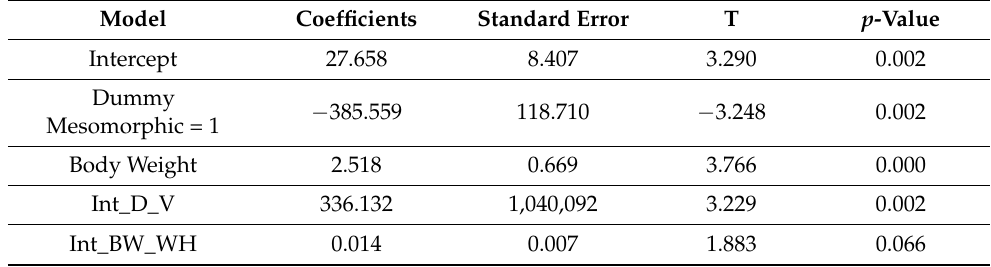
Table 8. Coefficients of stepwise backward regression for the dependent variable pelvic